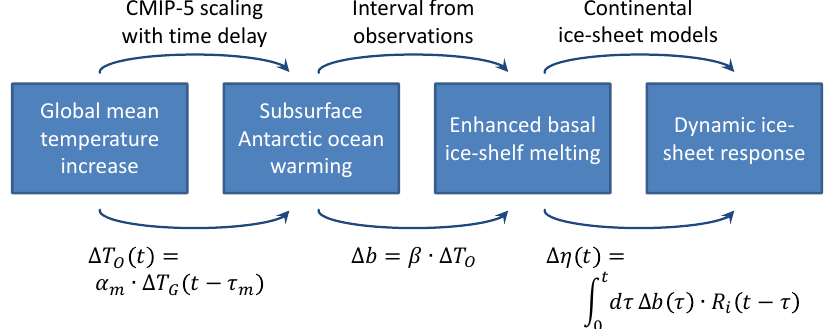
Figure 1. Schematic of procedure for the estimate of the uncertainty of the Antarctic dynamic contribution to future sea-level change. At each stage of the procedure, represented by the four boxes, a random selection is performed from a uniform distribution as indicated in the following. This procedure was carried out 50000 times for each RCP scenario to obtain the uncertainty ranges described throughout the study. First, one time evolution of the global mean temperature, 1 T , was selected randomly out of an ensemble of 600 MAGICC-6.0 G simulations. Second, 1 of 19 CMIP-5 climate models was selected randomly to obtain the scaling coefficient and time delay between the global mean temperature surface warming, 1 T , and the subsurface oceanic warming, 1 T . Third, a basal melt sensitivity, β , was selected G O randomly from the observed interval to translate the oceanic warming into additional basal ice-shelf melting. Finally, one of the ice-sheet models is selected randomly to use the corresponding response function, R i , to obtain an ice discharge signal which is given in sea-level equivalent. The formulas describe the corresponding signal transformation at each